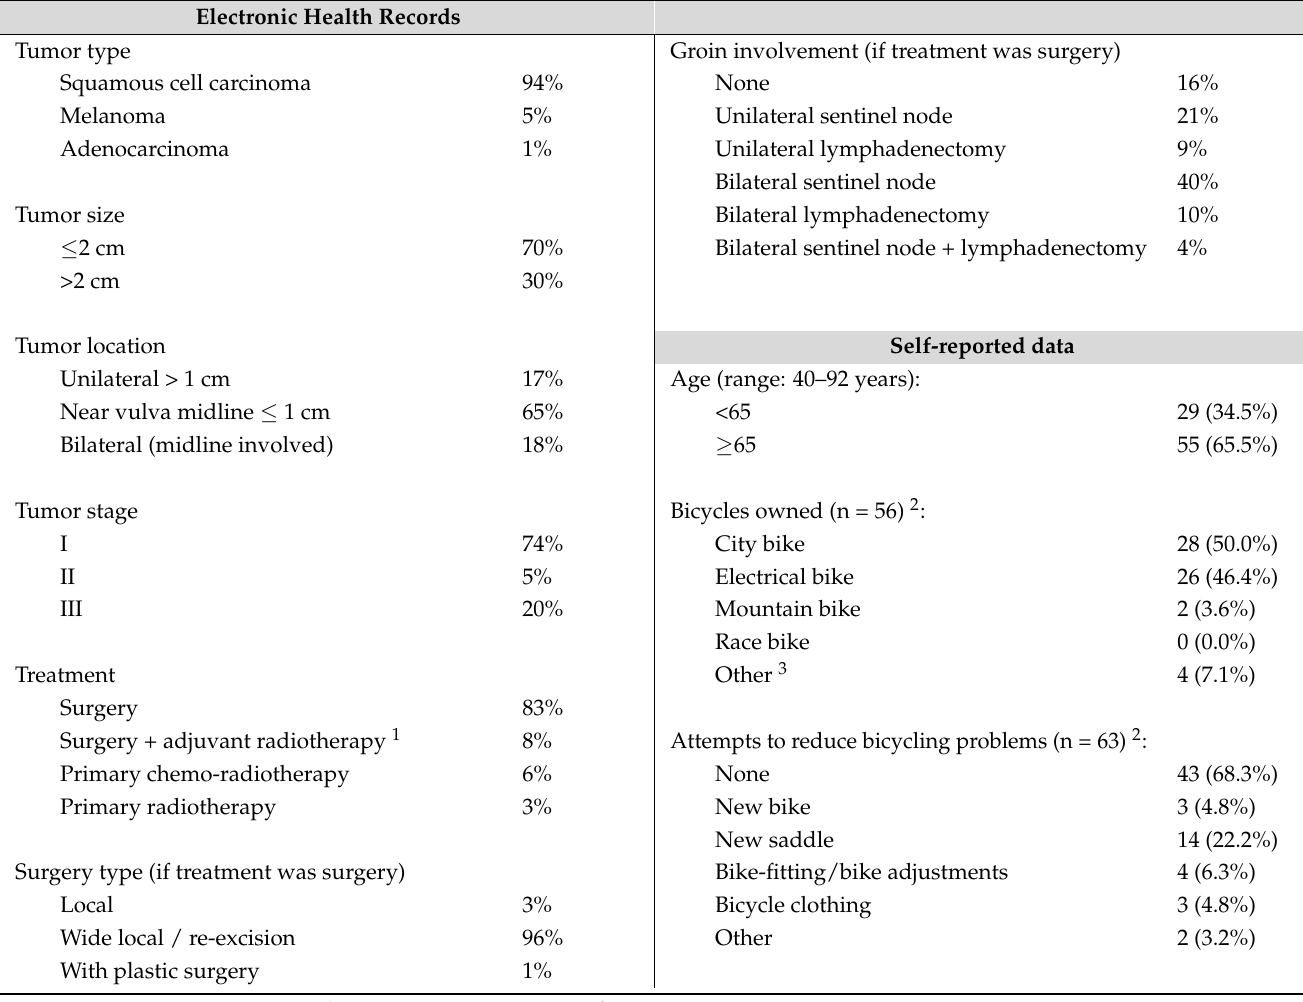
Table 1. Overview of characteristics and medical history of vulvar carcinoma patients. In addition, the table shows bicycle ownership, and previous attempts to reduce bicycling discomfort or